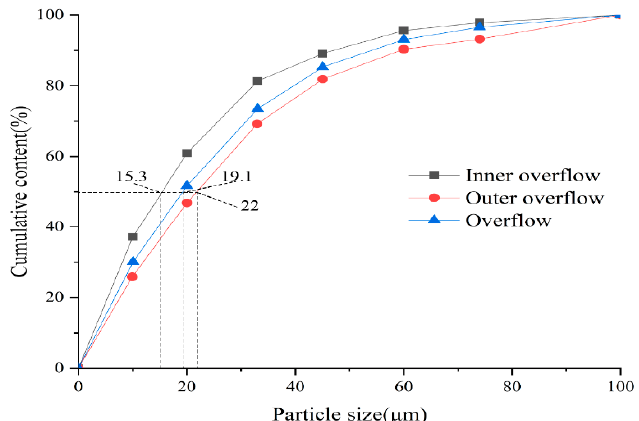
Figure 12. Particle size distributions of the three products of a double-overflow hydrocyclone.